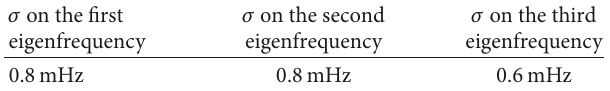
Table 4: Expected values of 𝜎 on the eigenfrequency